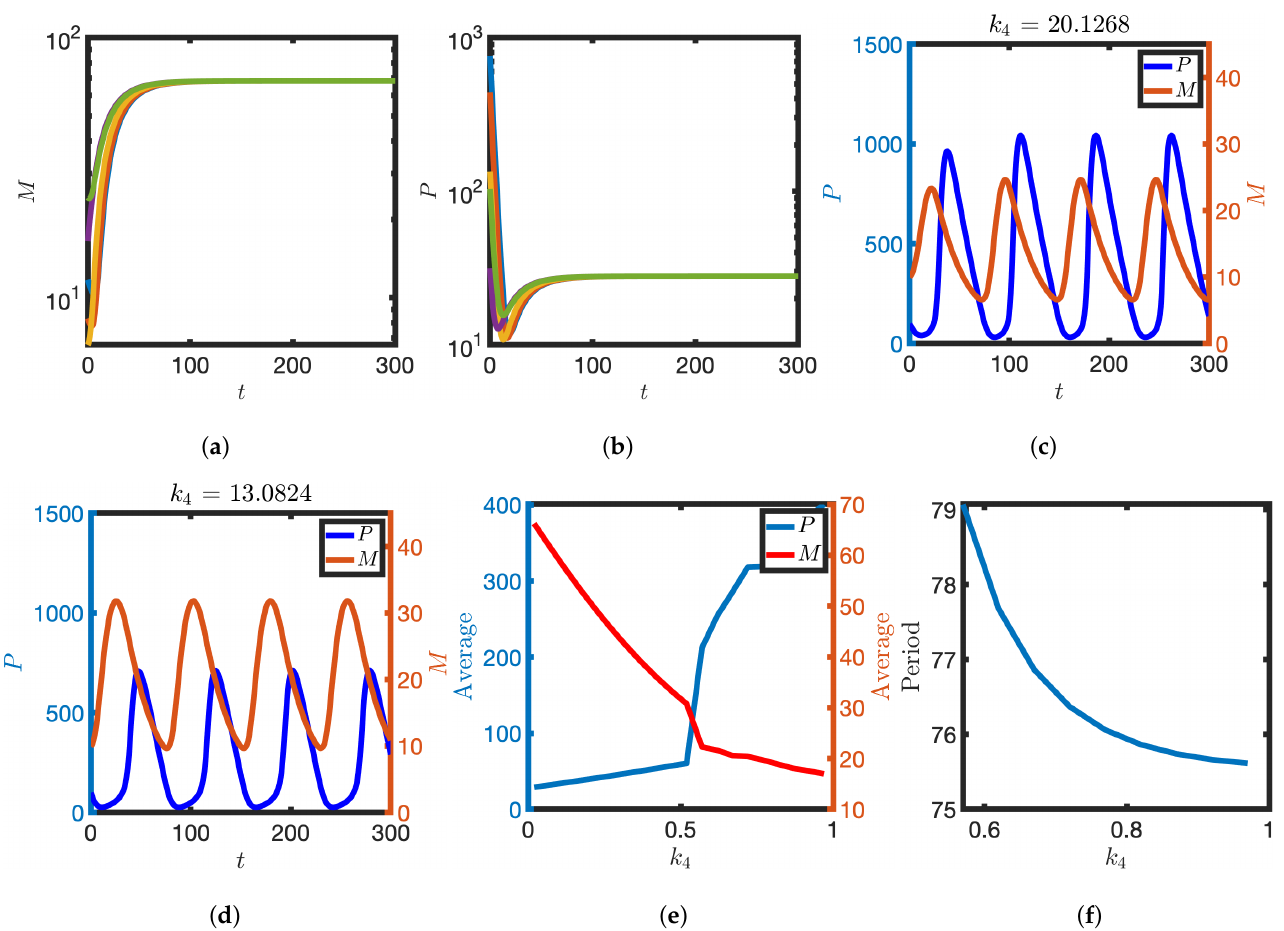
Figure 9. Perturbation of translation rates. ( a , b ) X-dependent translation is blocked ( k 4 = 0). mRNA ( a ) and protein ( b ) levels are plotted against time. Initial conditions given by each of the markers in Figure 7a. ( c – f ) Partial block of translation rates. M and P are plotted against time for larger ( c ) and smaller ( d ) translation rates. ( e ) Time-averaged levels of M and P (Equation (4)) are plotted against the parameter k 4 . ( f ) The period of the oscillator is plotted against the parameter k 4 . Equation (2) were solved numerically. Other parameter values as in Table